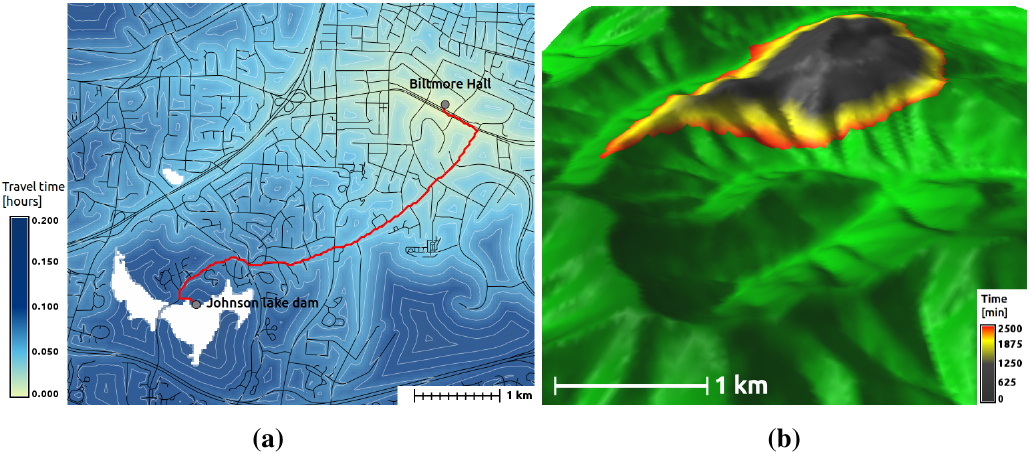
Figure 4. Images from the Geospatial Modeling and Analysis course exam and a project paper: ( a ) least cost path analysis done in GRASS GIS for the midterm exam; ( b ) fire spread modeling done in GRASS GIS for a final